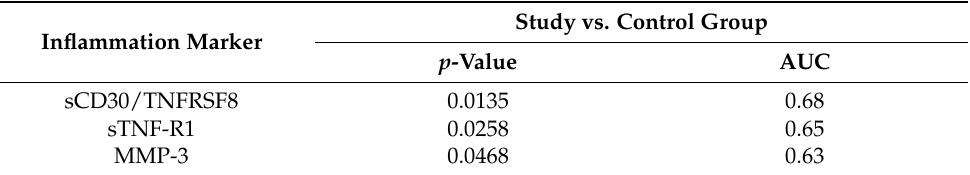
Table 4. Discriminatory value of serum inflammation markers expression showing significant p -values ( p < 0.05) and area under the receiver operating characteristic (ROC) curve (the Area Under the Curve—AUC > 0.630) between studied groups.